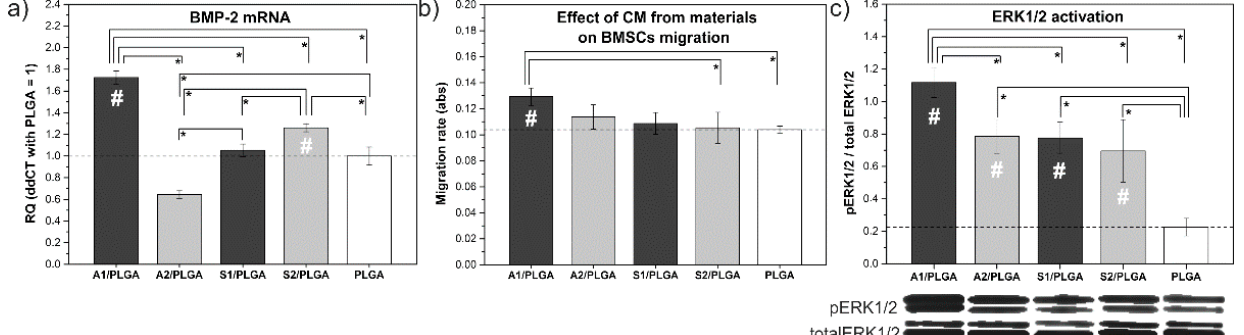
Figure 2. The mRNA levels of BMP-2 after 72-h BMSC treatment with CMs from studied composites ( a ); cell migration rate upon treatment with CMs ( b ); phospho-ERK 1/2 and total ERK 1/2 activation upon CM treatment ( c ). The results for control cells treated with CMs collected from PLGA are marked with a dashed line. # indicates significant increases from PLGA. Statistically significant differences between the materials and the control PLGA are marked with